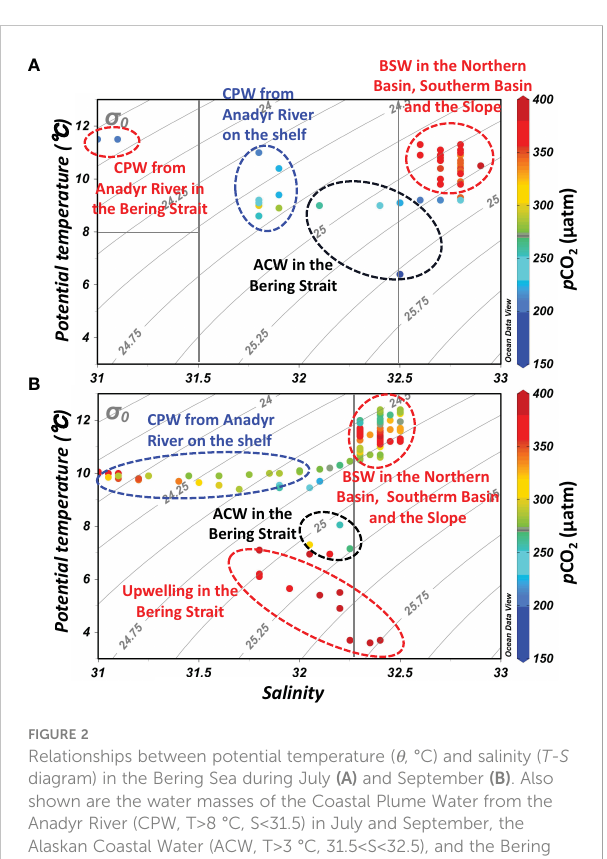
FIGURE 2 Relationships between potential temperature ( q , °C) and salinity ( T-S diagram) in the Bering Sea during July (A) and September (B) . Also shown are the water masses of the Coastal Plume Water from the Anadyr River (CPW, T>8 °C, S<31.5) in July and September, the Alaskan Coastal Water (ACW, T>3 °C, 31.5<S<32.5), and the Bering Summer Water (BSW, T>3 °C, 32.5<S) during both months (Itoh et al., 2015; Song et al., 2016; Wang et al., 2022), and the upwelling in September. Note that the temperature and salinity boundaries are not precise.